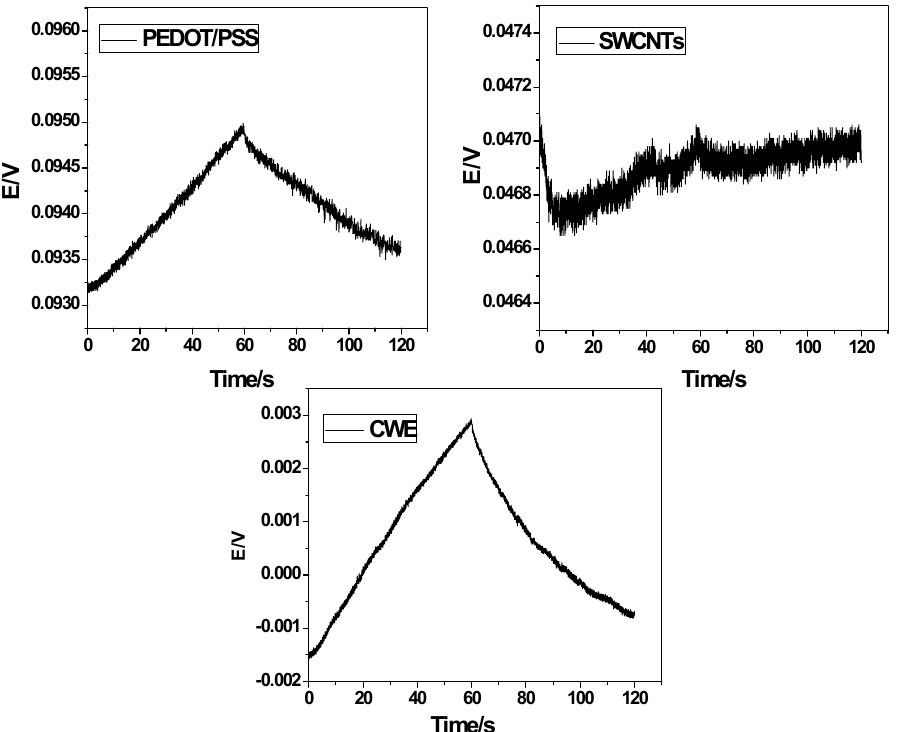
Figure 2. Chronopotentiometric results done for GC/Cu 2+ -ISEs (CWE), GC/PEDOT/PSS/Cu 2+ -ISEs and GC/SWCNTs/Cu 2+ -ISEs, applying anodic/cathodic current of 10 nA, in 0.01 M NaCl.